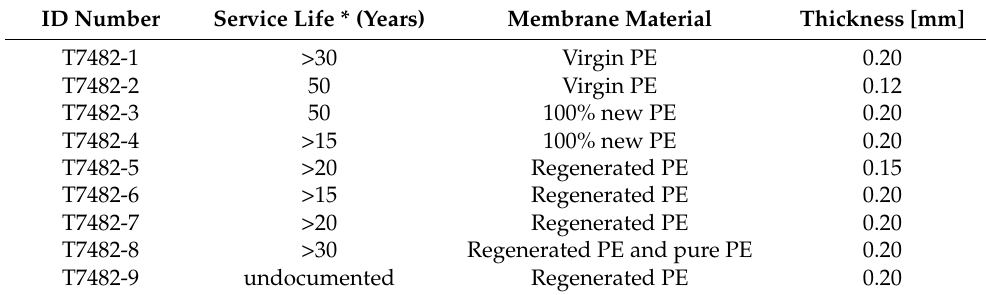
Table 1. Properties of membranes evaluated in the study as supplied by